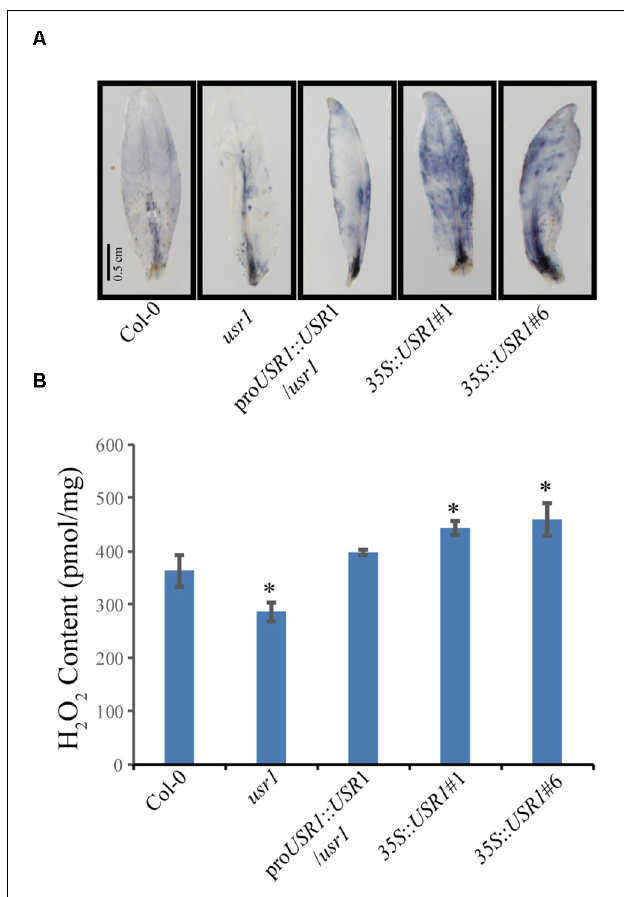
FIGURE 5 | AtUSR1 affects ROS accumulation. (A) The NBT staining results of leaves from different genotypes. (B) Accumulation of H 2 O 2 in detached leaves of different genotypes as indicated. *Indicate significant difference at 0.01 < P < 0.05 levels using student’s t -test. Data are shown as the mean ± SD from three independent